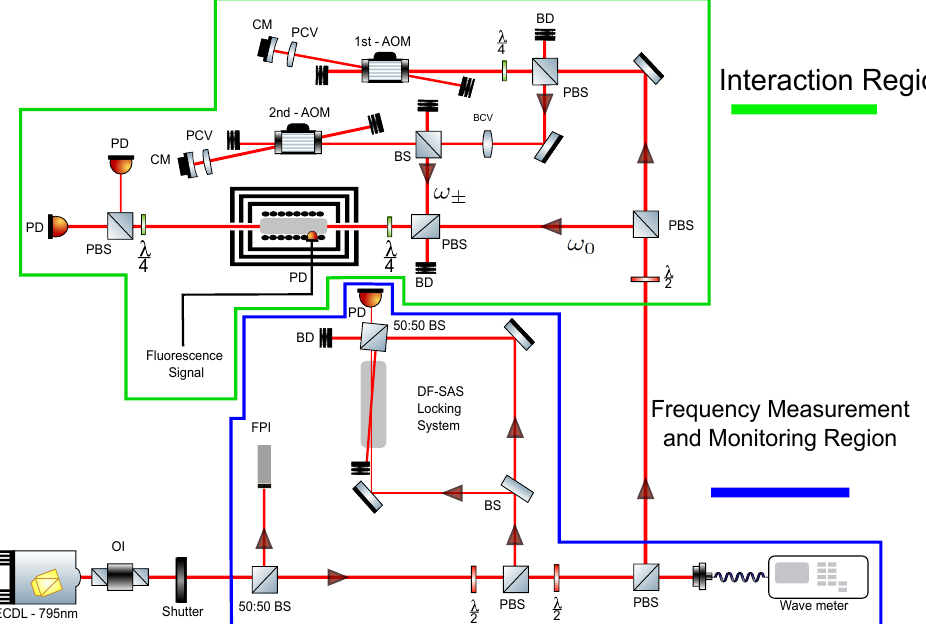
Figure 1. Optical setup of the experiment. The setup is divided into two regions: the frequency measurement and monitoring region in blue, and the Interaction region in green, which highlights the main part of the experiment. In the figure, (ECDL) is external cavity diode laser, (DF-SAS) is Doppler free saturated absorption spectroscopy setup for locking purposes, (FPI) is a Fabry–Pérot interferometer, (OI) is an optical isolator, (BS) is a beam splitter, (PBS) is a polarizing beam splitter, ( λ ) is a half-wave plate, ( λ ) is a quarter-wave plate, (PCV) is a plano-convex lens, (CM) is a concave 2 4 mirror, (BCV) is a biconvex lens, (BD) is a beam dump, (PD) is a photodiode, and the AOM is the Bragg cell. The two AOMs are in double pass configuration, where the first AOM shifts the frequency up, whereas the second AOM shifts the frequency down and is used for